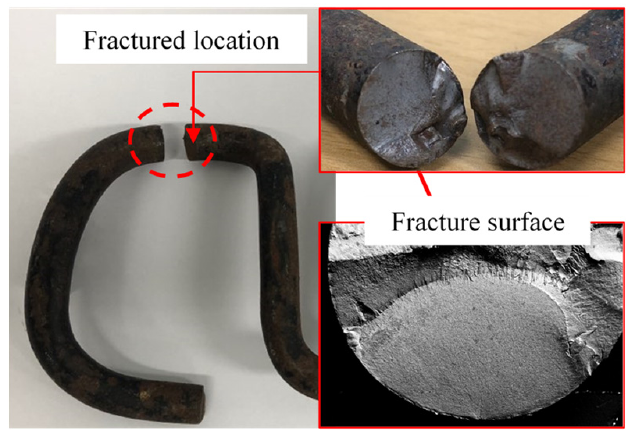
Figure 2. A fractured tension clamp.